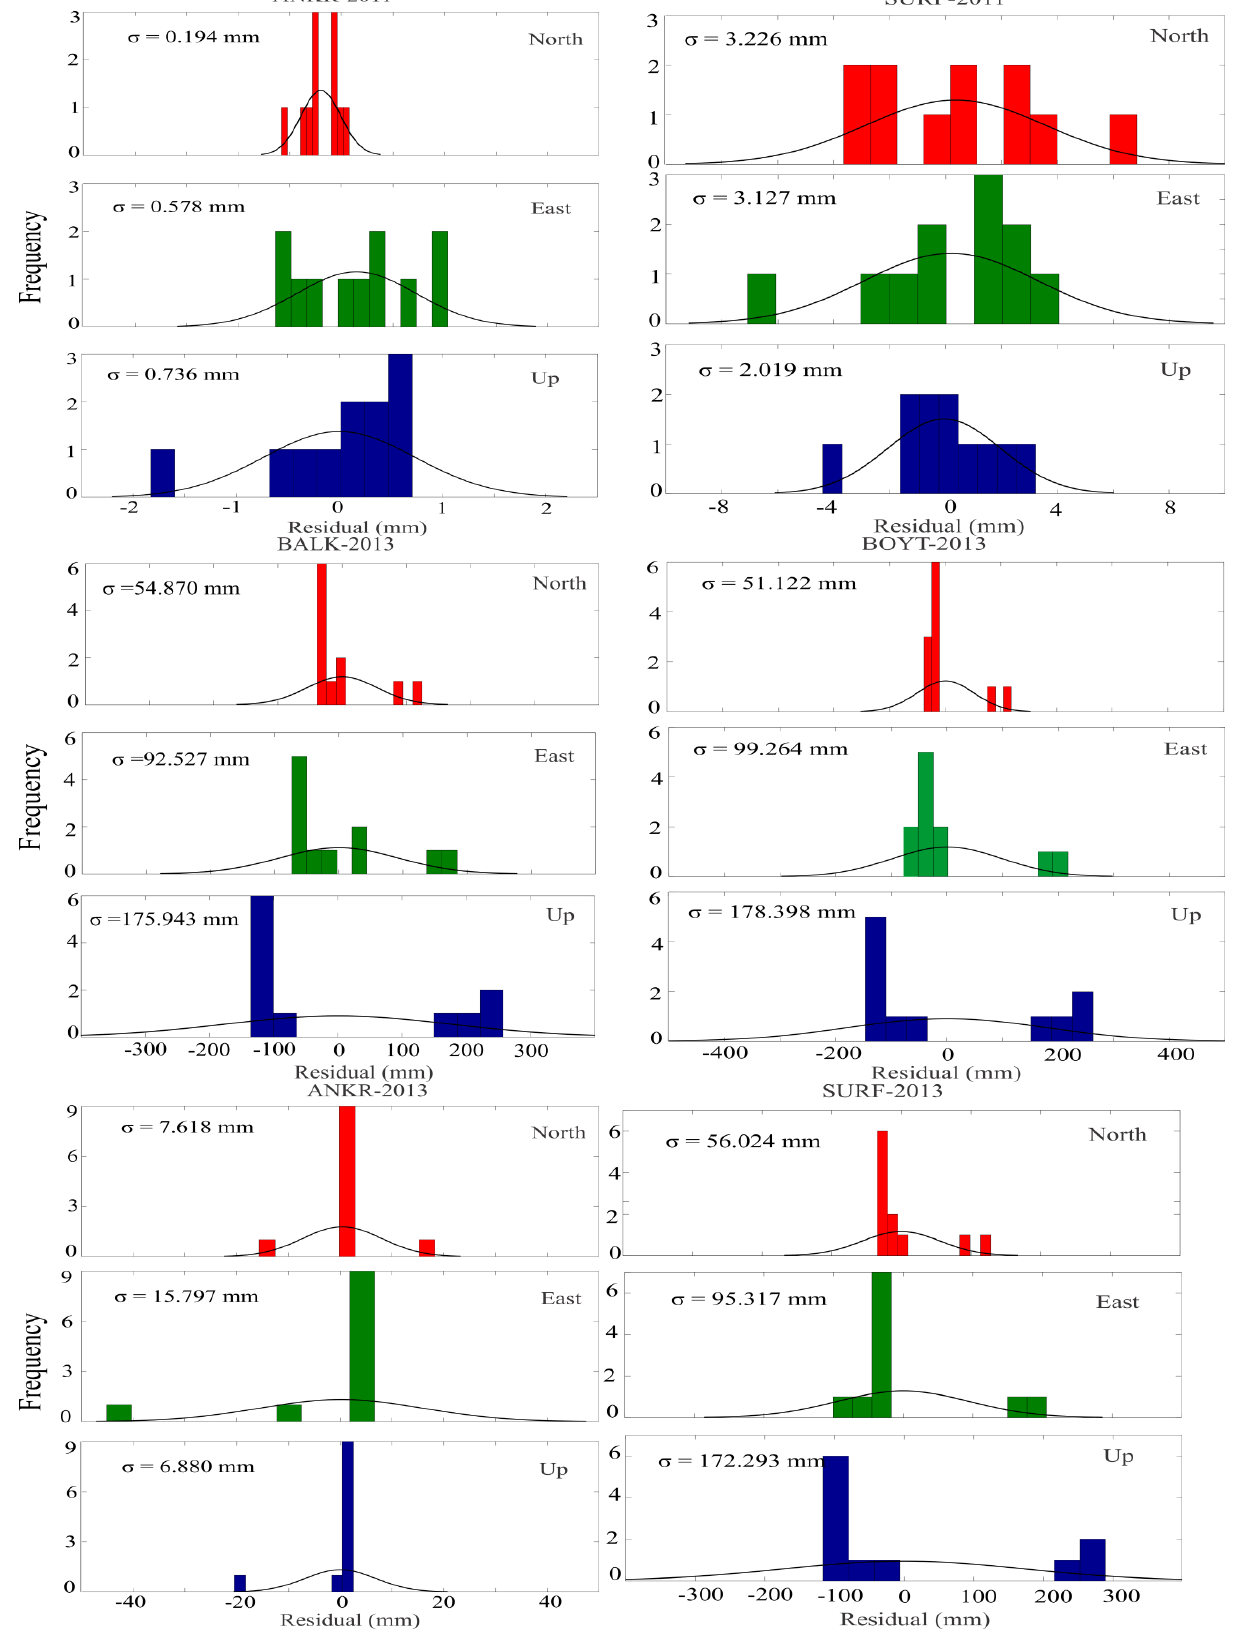
Figure 3: The coordinate reliability of GNSS sites from the year 2009 to